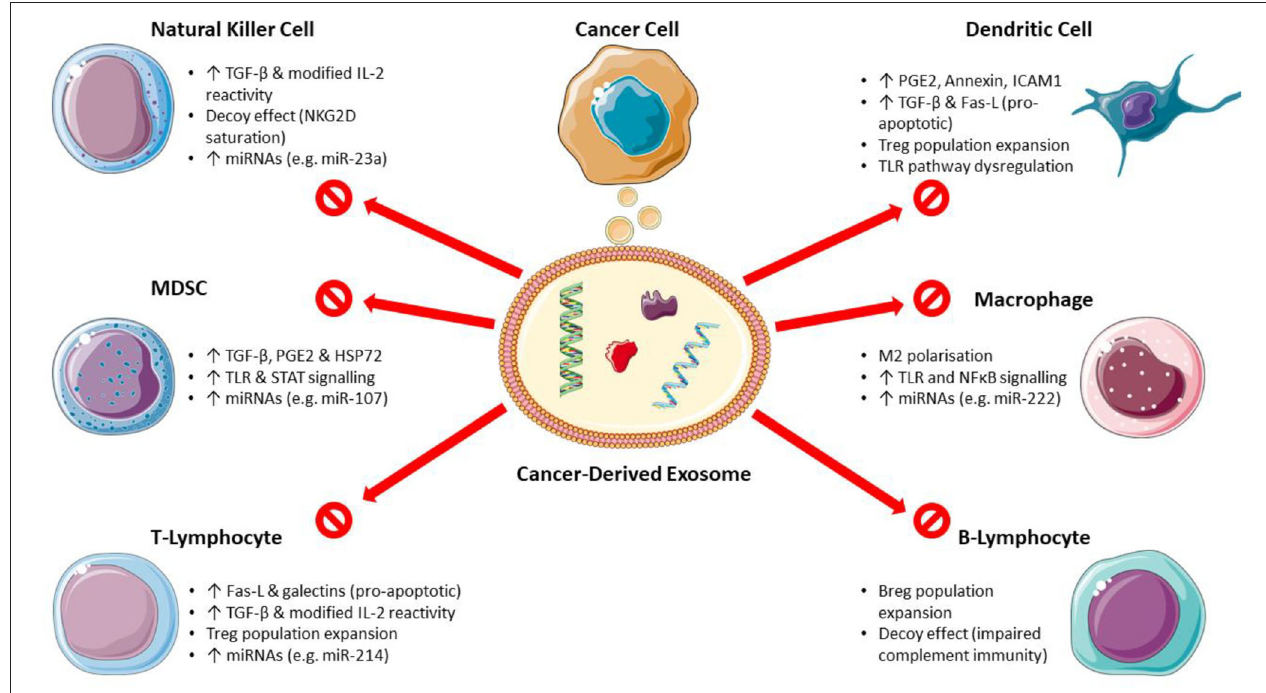
FIGURE 1 | Mechanisms of cancer-derived exosome mediated immunosuppression. (Breg, regulatory B-lymphocyte; Fas-L, Fas ligand; HSP, heat shock protein; ICAM1, intercellular adhesion molecule 1; MDSC, myeloid-derived suppressor cells; miRNA, microRNA; PGE2, prostaglandin E2; STAT, signal transducer and activator of transcription; TGF- β , transforming growth factor- β ; TLR, toll-like receptor; Treg, regulatory T-lymphocyte). Images used from Servier Medical Art (https:// smart.servier.com) under CC BY v3.0